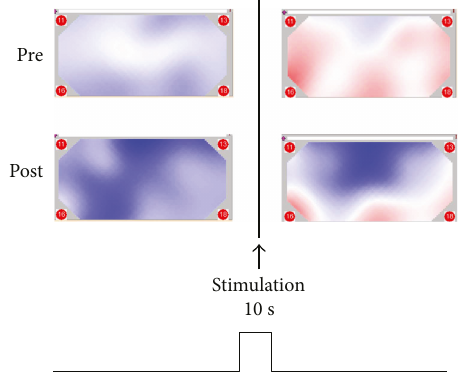
Figure 2: Near-infrared spectroscopic (NIRS) images of the frontal cortex of a subject with pain in the left thigh. Pre shows the images obtained from the subject to whom the pyramidal thorn patches have not yet been applied. Post shows the same subject after patches have been applied. The lower parts of the Pre images expressed in red are the frontal cortex, indicating that the concentration of oxyhemoglobin in the blood in the frontal cortex increased after maintaining a posture with pain for 10sec. The patch application relieved the pain sensation, which can be judged in the Post image (in blue) with